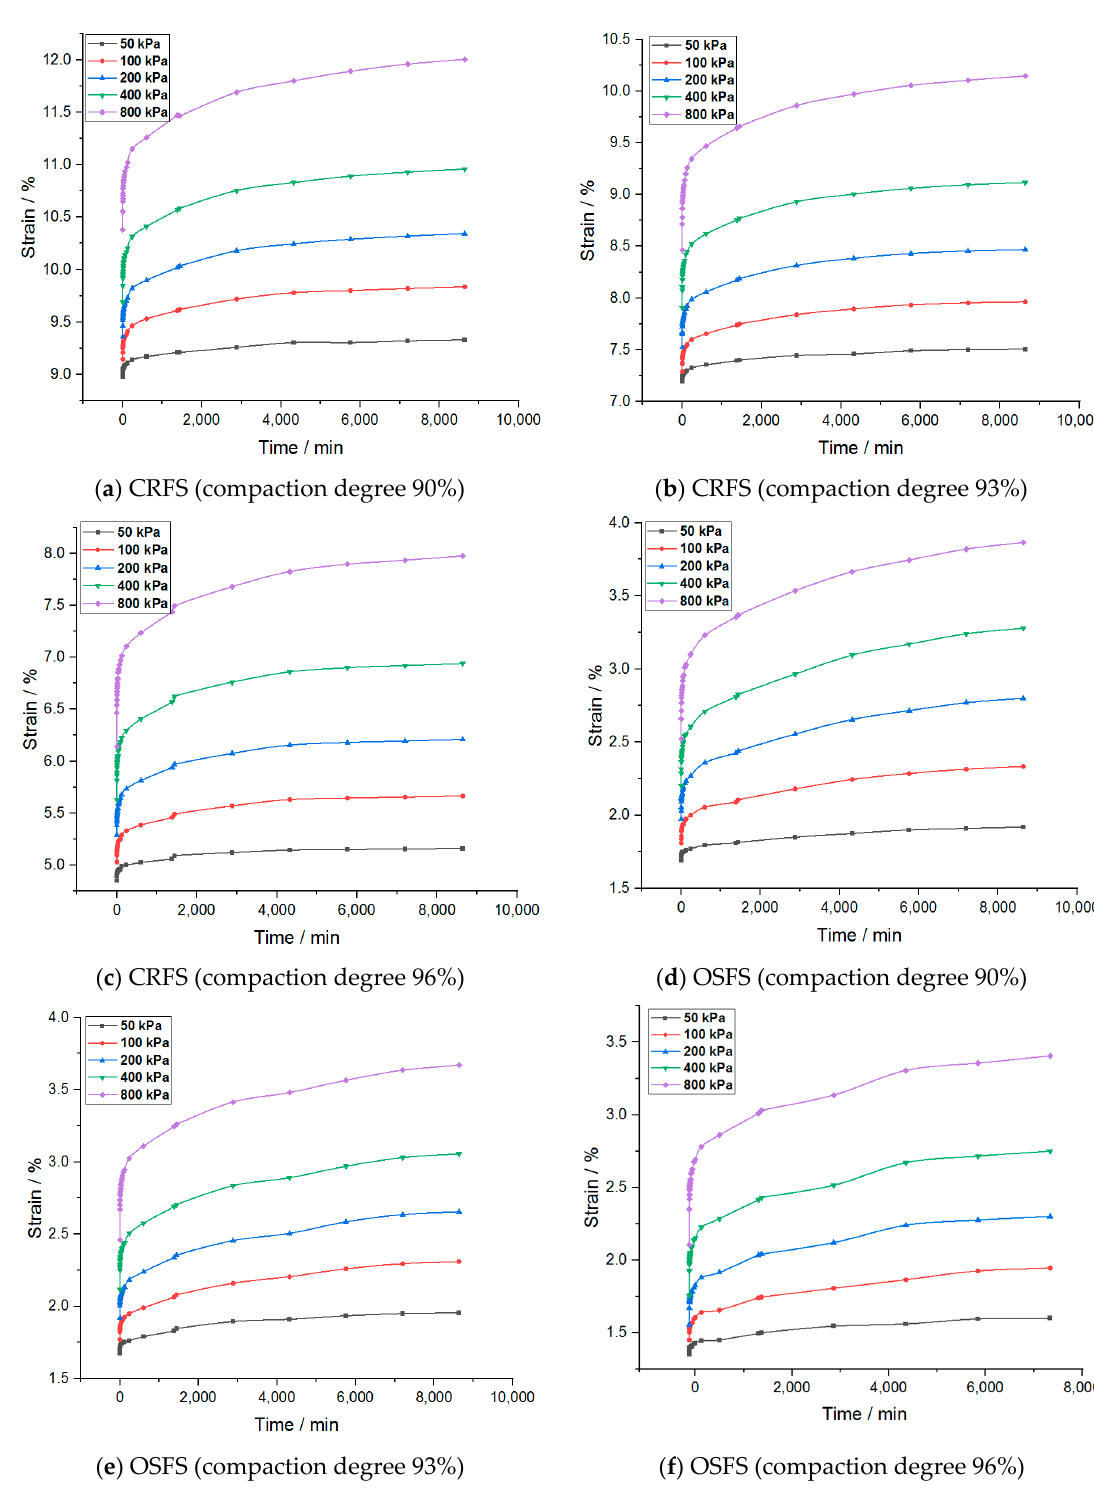
Figure 6. Strain–time curves of samples with different compaction degrees after processing. After analyzing the treated curve cluster, it can be concluded that the strain–time curve presents two stages: decay creep and constant velocity creep. Due to the restriction of the lateral limit, the soil is constantly compacted and cannot move laterally, so it cannot show the failure form of soil in the accelerated creep stage. An instantaneous strain will be generated at the moment when the load is applied, which increases with the increase of stress. When the stress level is low, the creep curve shows a stable attenuation. The amount of deformation gradually increases with the increase of time. After 4 h, the in- crease of deformation slows down and finally becomes stable. In the stable stage, the strain rate tends to zero with time. The strain rate of the modified soil is obtained by taking the first derivative of the strain–time curve, as shown in Figures 7 and 8.